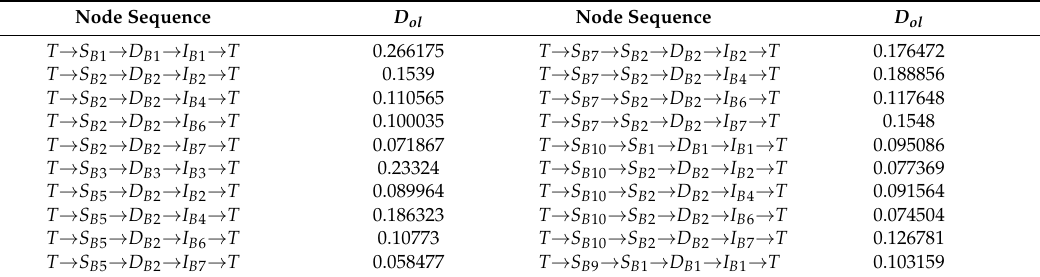
Table A1. Parameters of